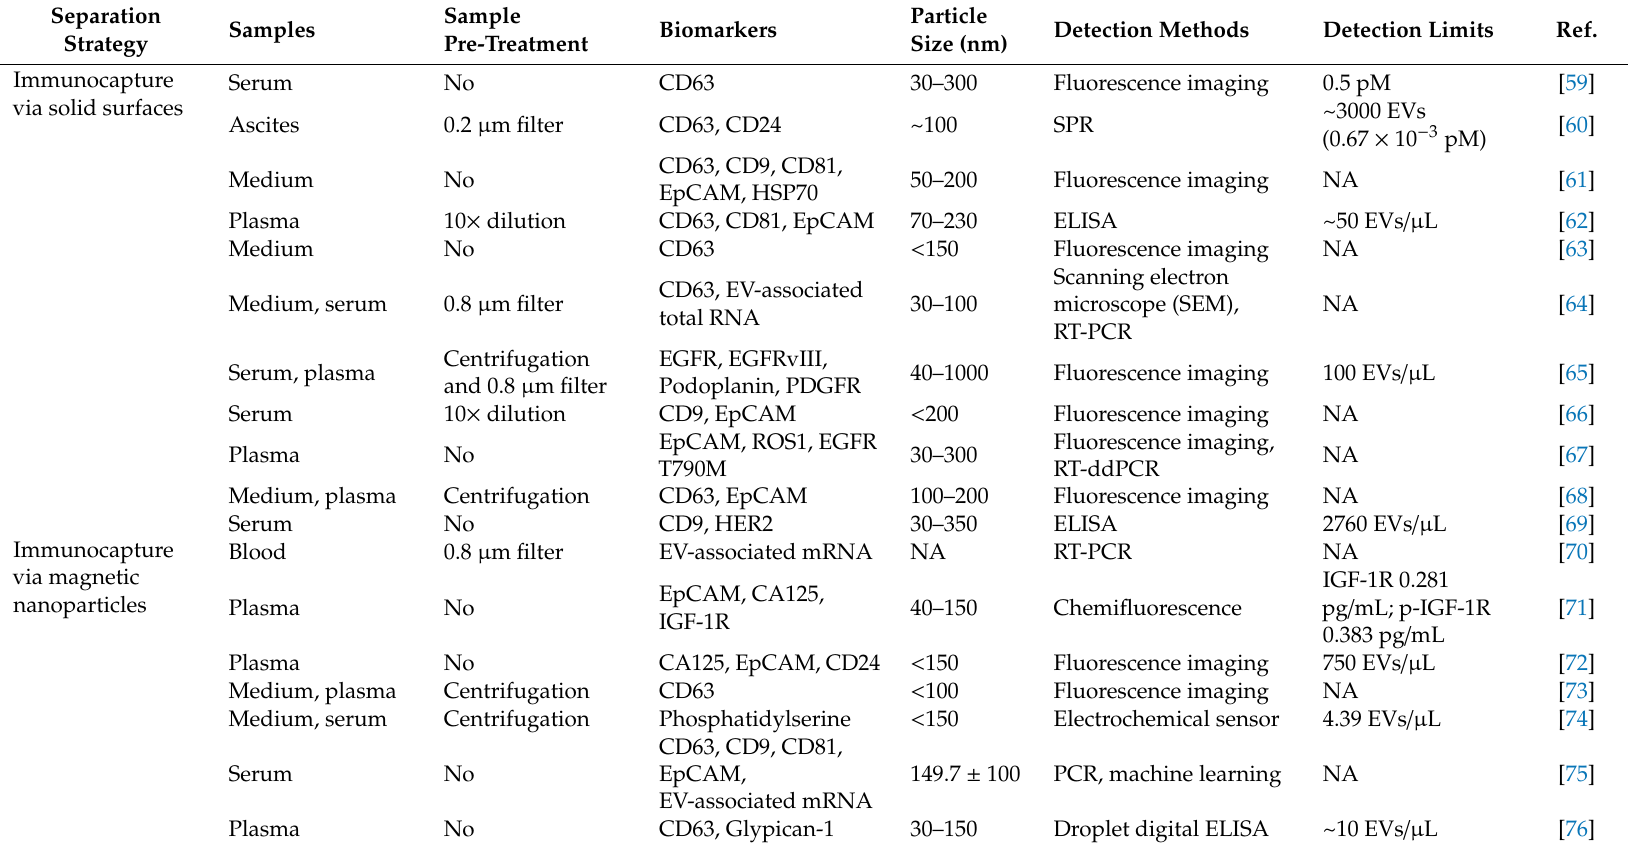
Table 1. EV separation and detection on microfluidic chips. NA–not